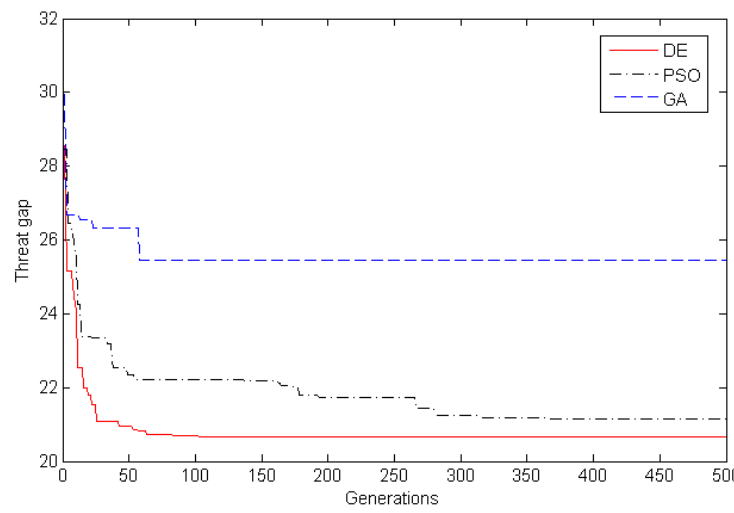
Figure 8. Results of the three algorithms.